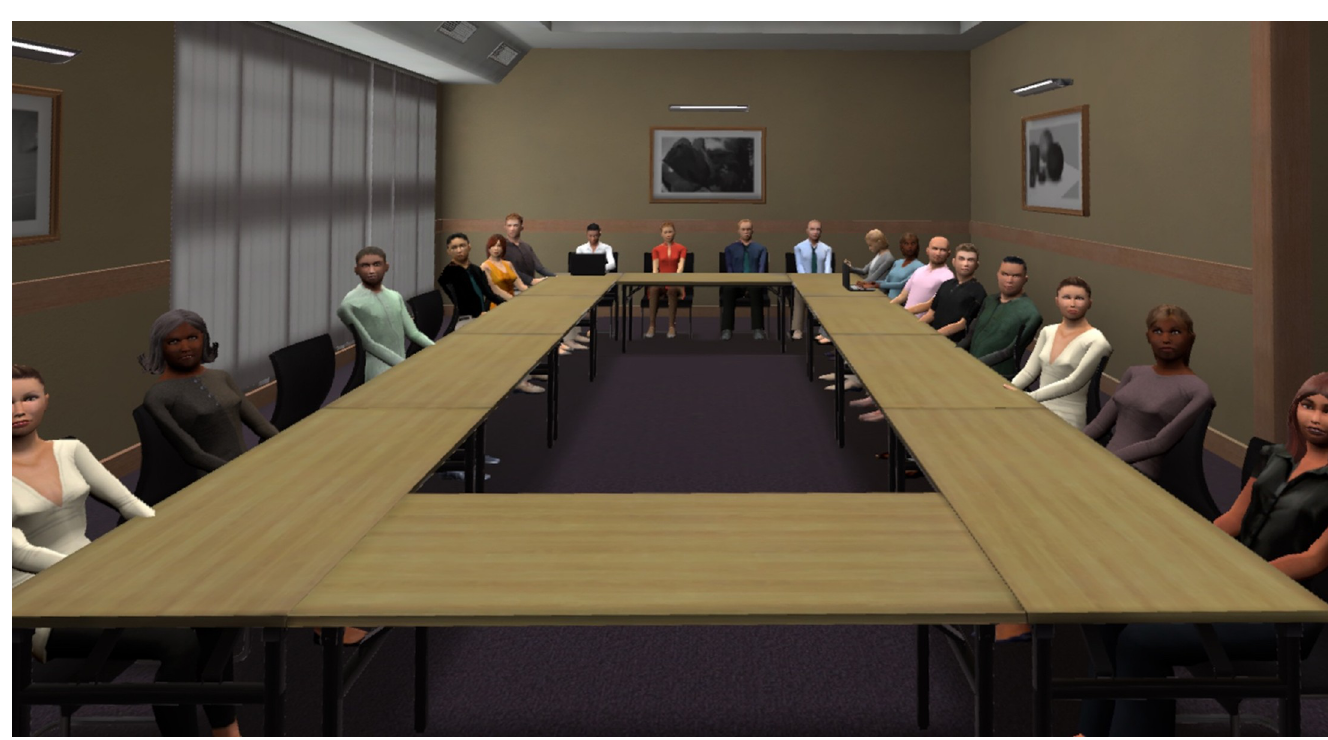
Fig 2. Example of medium room scenario.